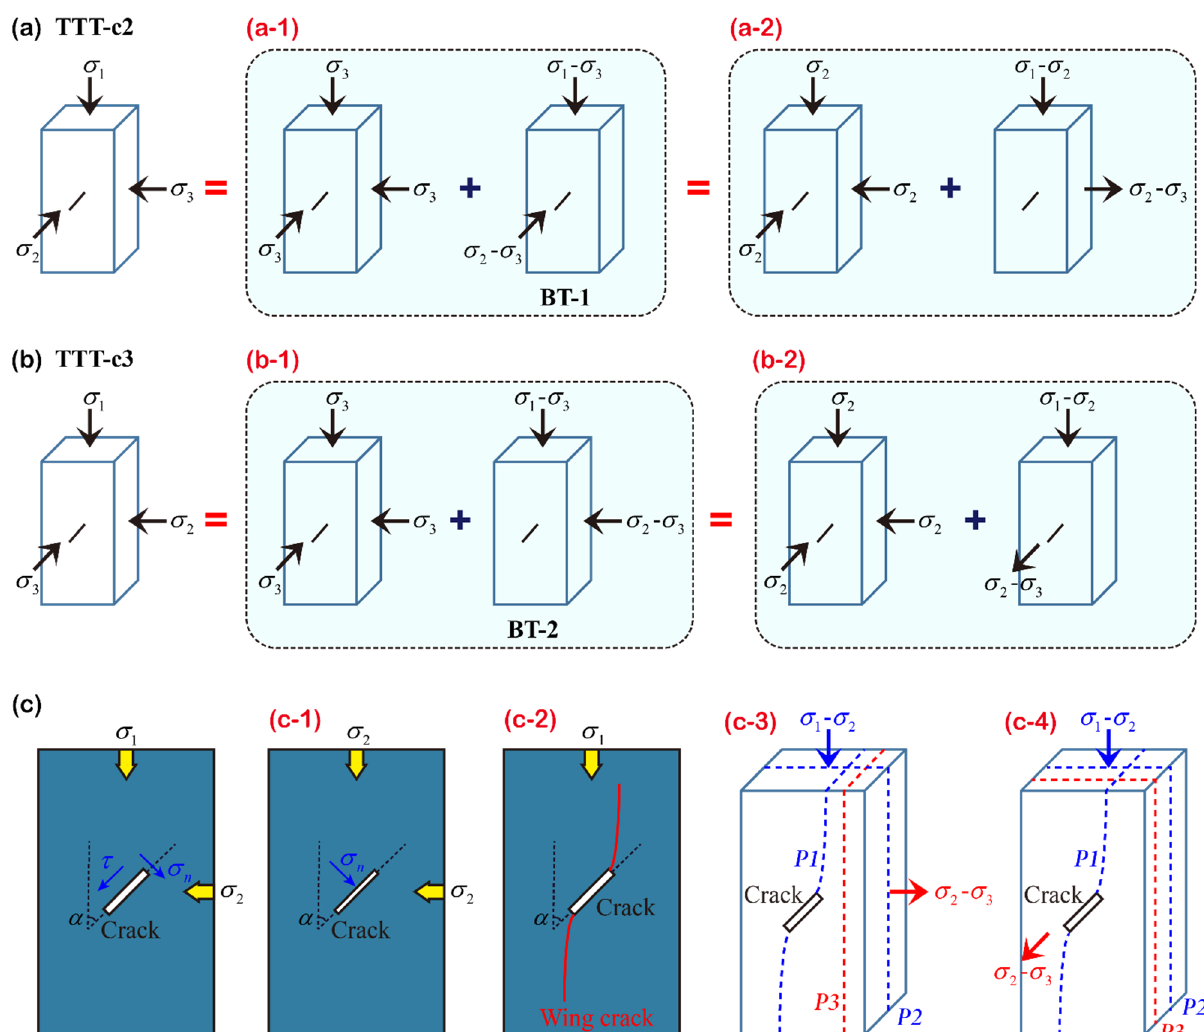
Figure 13. Fracture mechanism of rock with prefabricated fractures: ( a ) the intermediate principal stress along the direction of prefabricated fracture; ( b ) the intermediate principal stress perpendicular to the direction of prefabricated fracture; ( c ) the law of fracture expansion direction.